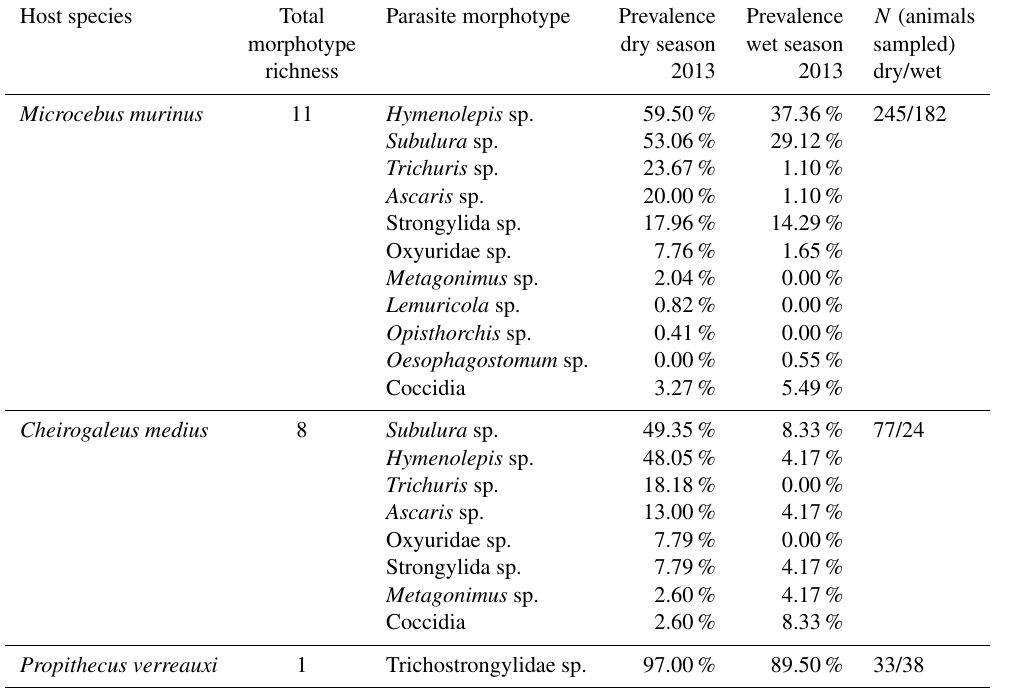
Table 3. Seasonal prevalence of intestinal parasites for three sympatric lemur species at Kirindy Forest, Madagascar, for the year 2013. Host